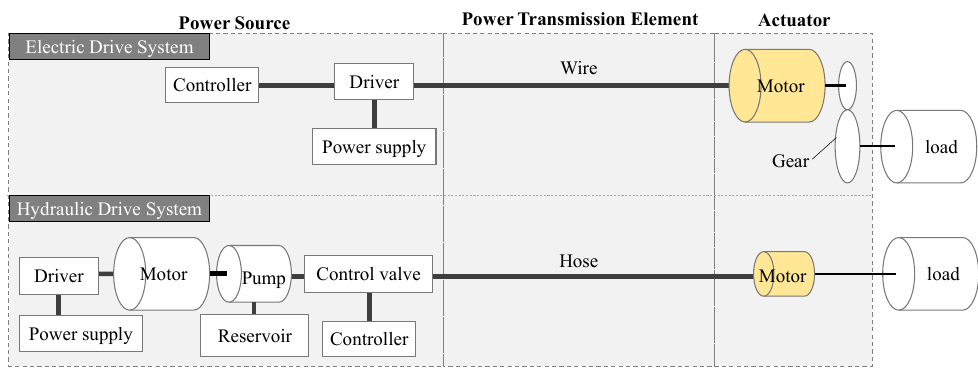
Figure 17. Configuration example of electric and hydraulic drive system.